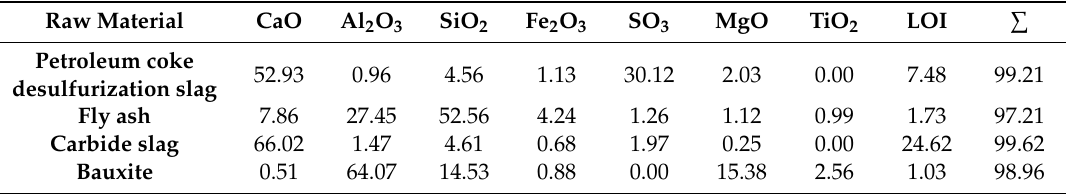
Table 1. Chemical composition of the raw materials, wt.%.